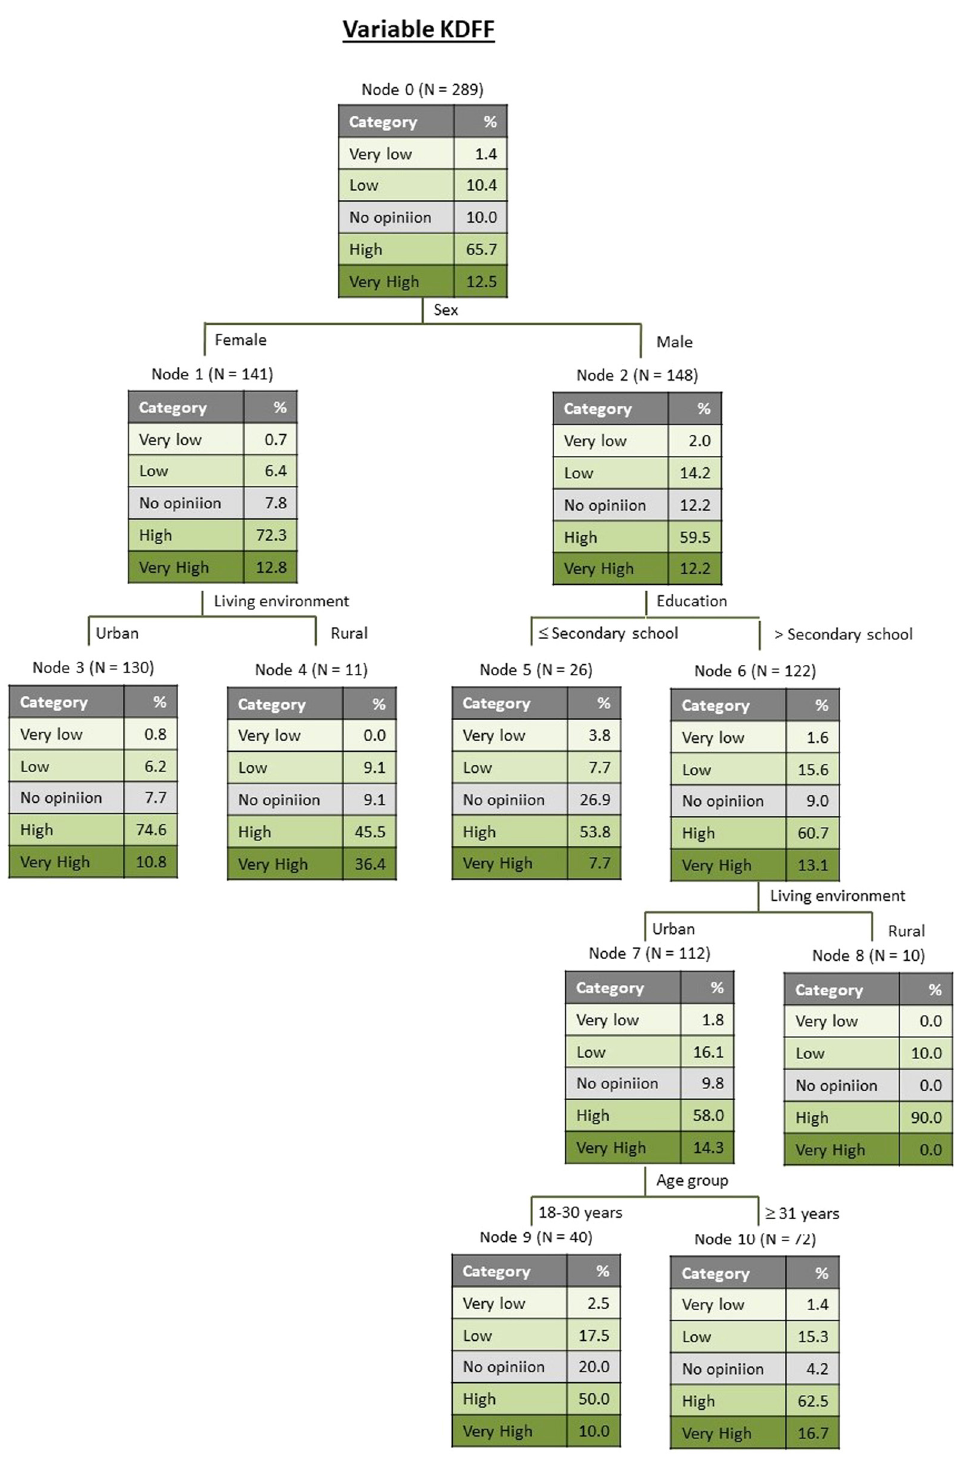
Figure 1: Classi fi cation tree for variable CRT algorithm, which searched for all possible variables and all possible values to fi nd the best split — the question that splits the data into two parts with maximum homogeneity ( see Figures 1 and 2 ) . Figure 1